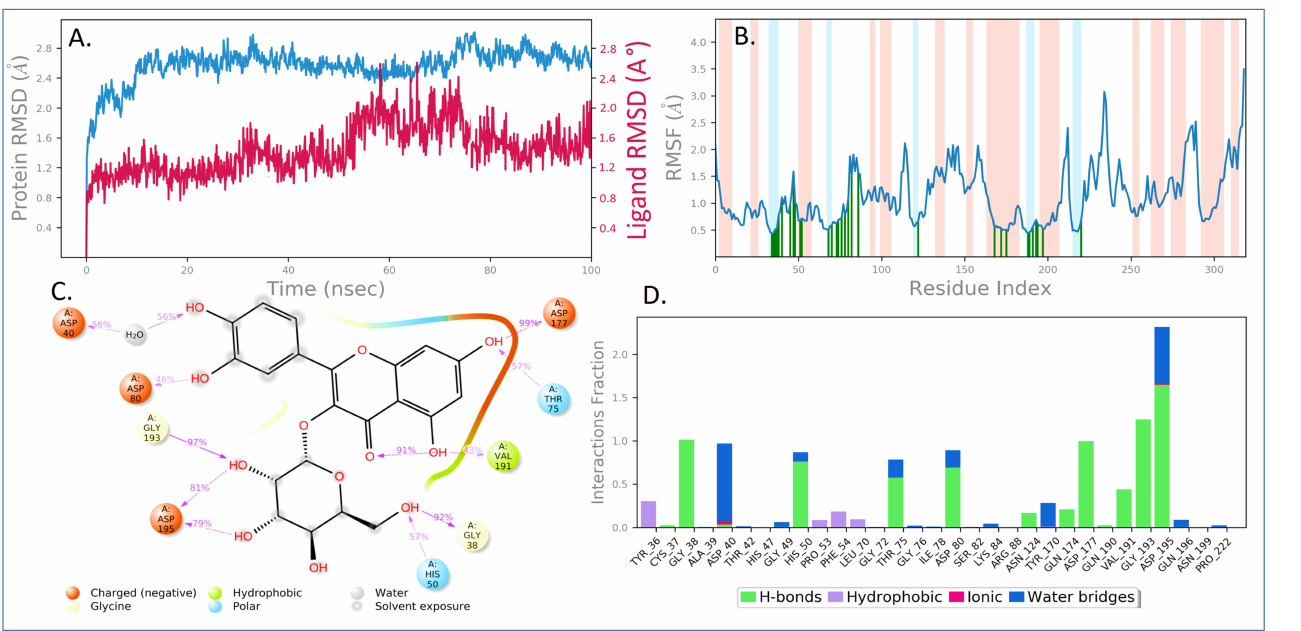
Figure 8. MD simulation analysis of hyperoside in complex with S. aureus tyrosyl-tRNA synthetases ( TyrRS ) (PDB ID: 1JIJ): ( A ) time dependent RMSD (protein C α atoms RMSD is shown in teal blue color while the RMSDs of hyperoside with respect to protein are shown in brown color); ( B ) protein C α atoms RMSF; ( C ) 2D diagram of ligand interactions that occurred more than 30.0% of the simulation time; and ( D ) protein–ligand contact analysis of throughout the